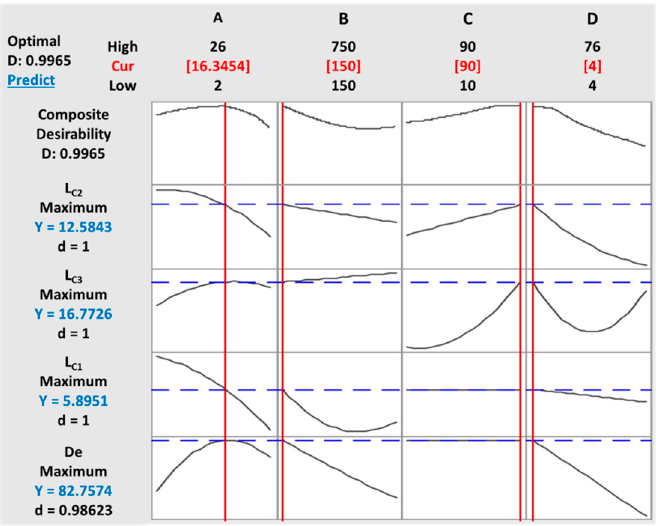
Figure 9. Optimization plot of multiple responses under the defined parameters: ( A ) initial concentration, ( B ) time, ( C ) duty cycle ( DC ), and ( D ) voltage.